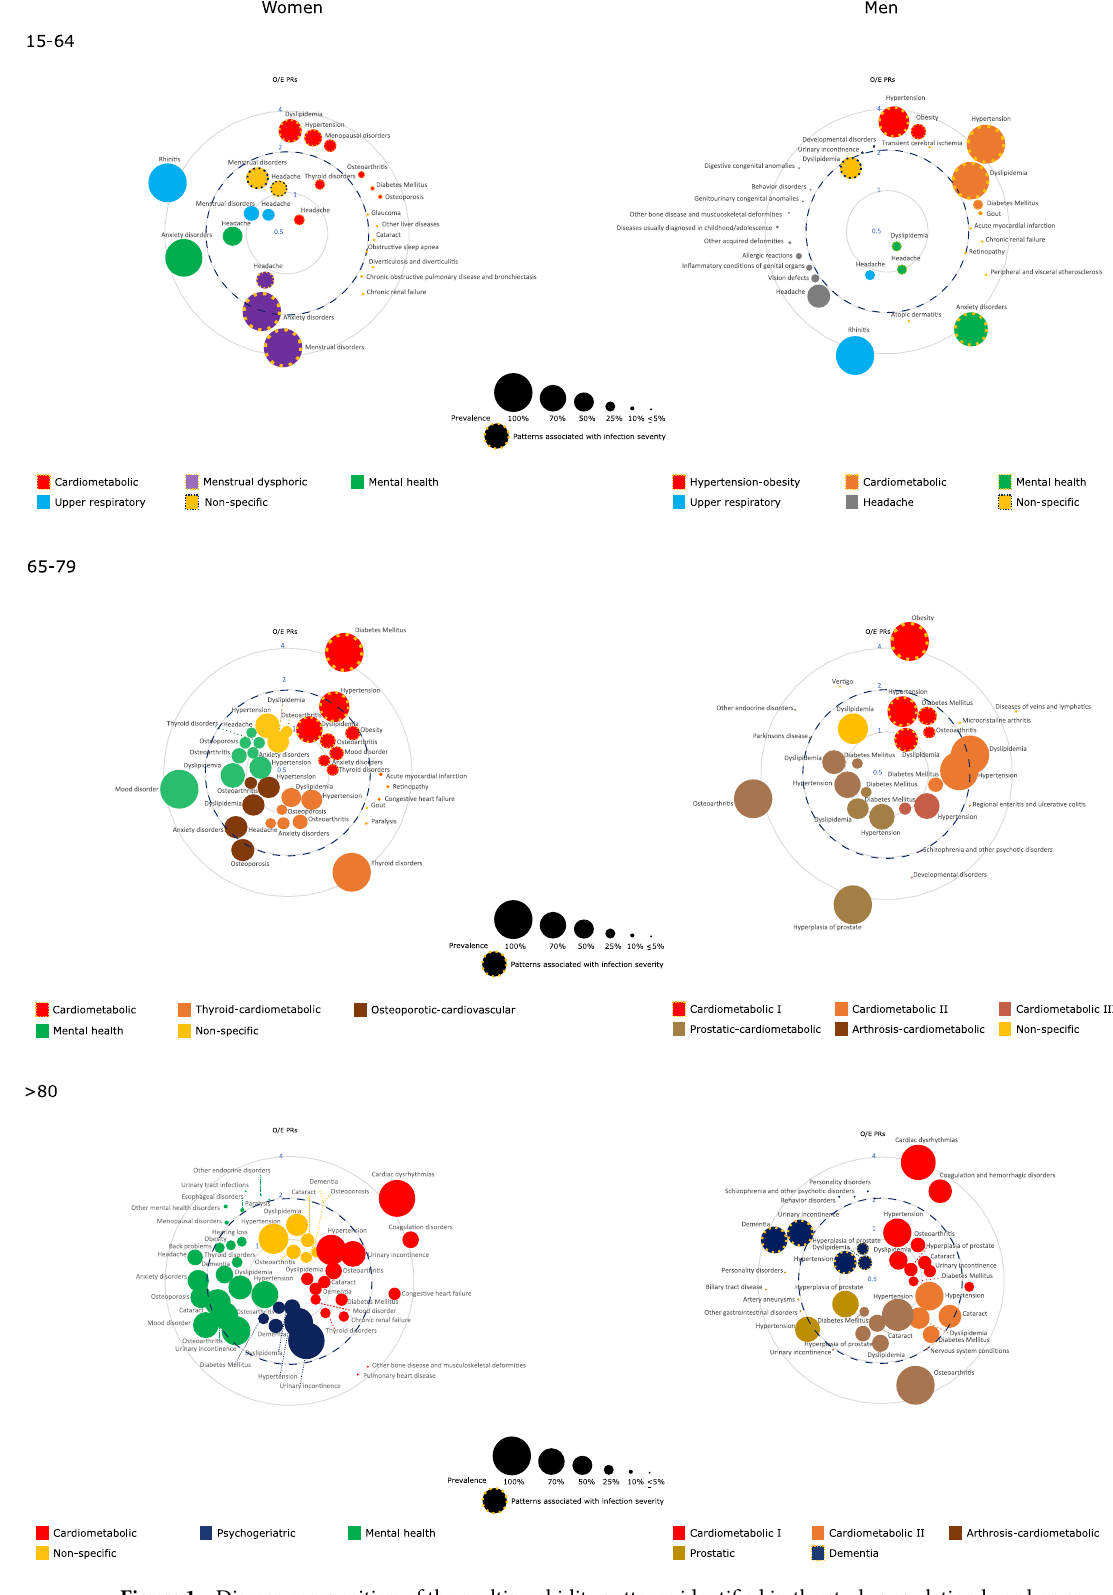
Figure 1. Disease composition of the multimorbidity patterns identified in the study population based on sex and age, accordign to prevalence (proportional to node size) and observed/expected prevalence ratios (O/E PRs). A disease was included as a part of a pattern when presented a prevalence greater than 25% and/or a O/E PR ≥ 2 (witha prevalence of at least 1%). In broken lines patterns with statistically significant age-adjusted odds ratios of infection